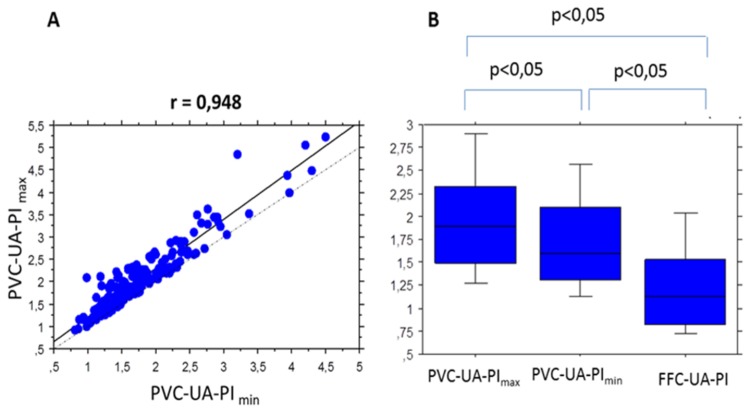
A: Correlation between the two UA-PIs measured at the perivesical (PVC) segment.The larger UA-PI value of the pair was designated PVC-UA-PImax and the smaller, PVC-UA-PImin. The dotted line depicts the line of equality. B: Comparison between the UA-PI measured at the PVC segment and in the free-floating cord (FFC).